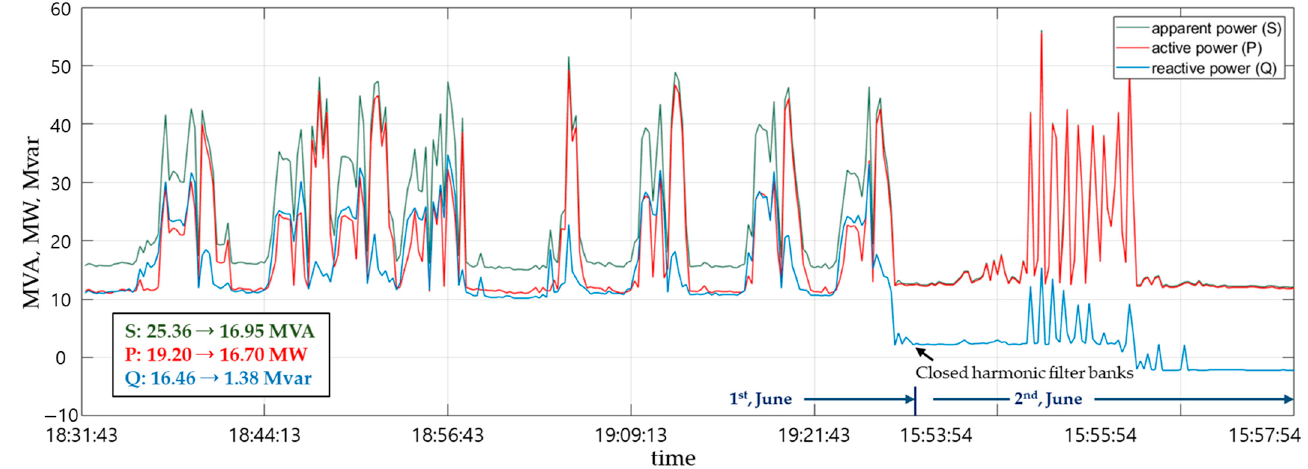
Figure 7. Measured S , P , and Q on plate mill system.